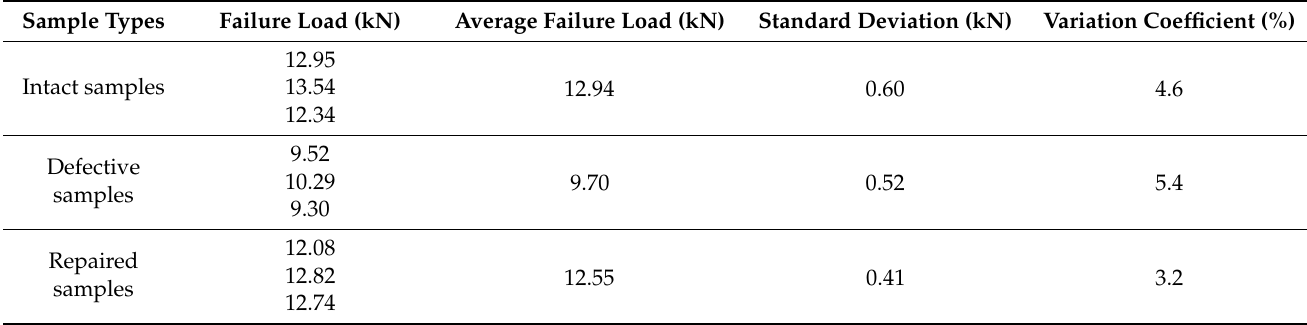
Table 3. Failure loads of the intact, defective and repaired composite